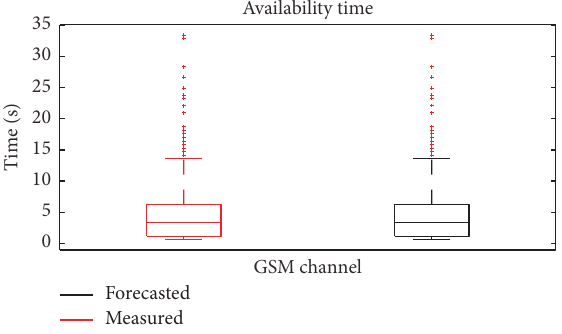
Figure 7: Availability time of forecasted GSM channel. Table 4: Experimental values of 𝜎 𝑆𝑘 and 𝜎 𝑁 for